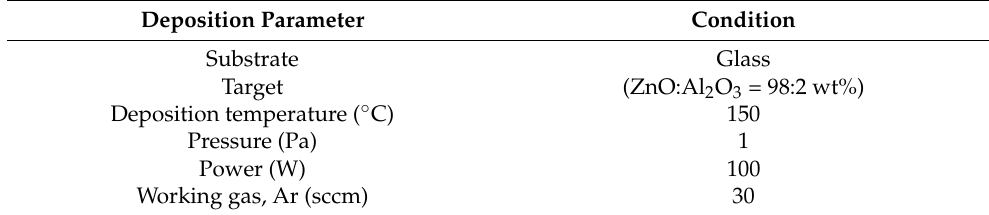
Table 1. Deposition conditions of AZO film by RF magnetron